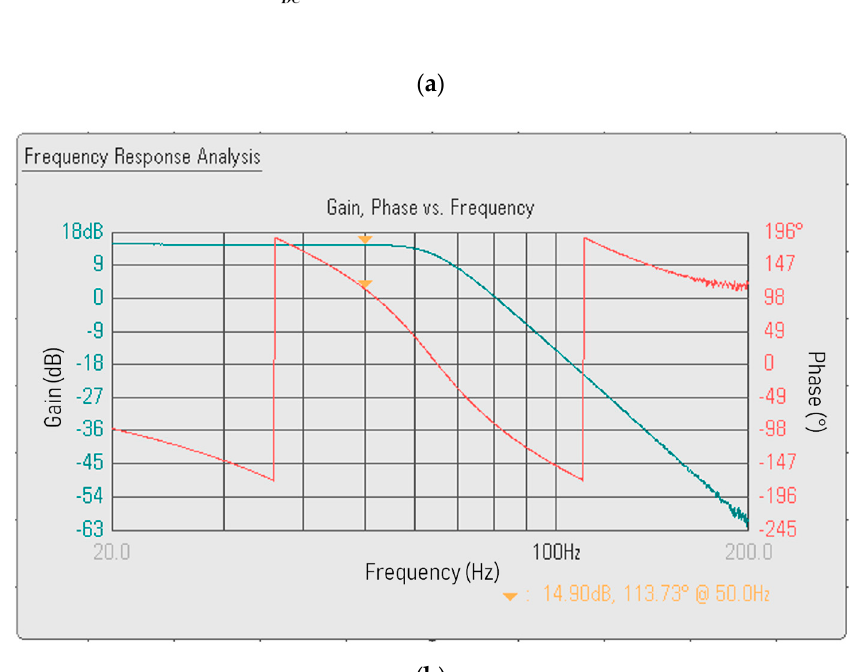
Figure 4. ( a ) Schematic of each one of the four stages of the line frequency 8th-order low-pass filter (LPF). ( b ) Measured Bode plot of the cascade of the difference amplifier and the 8th-order LPF.